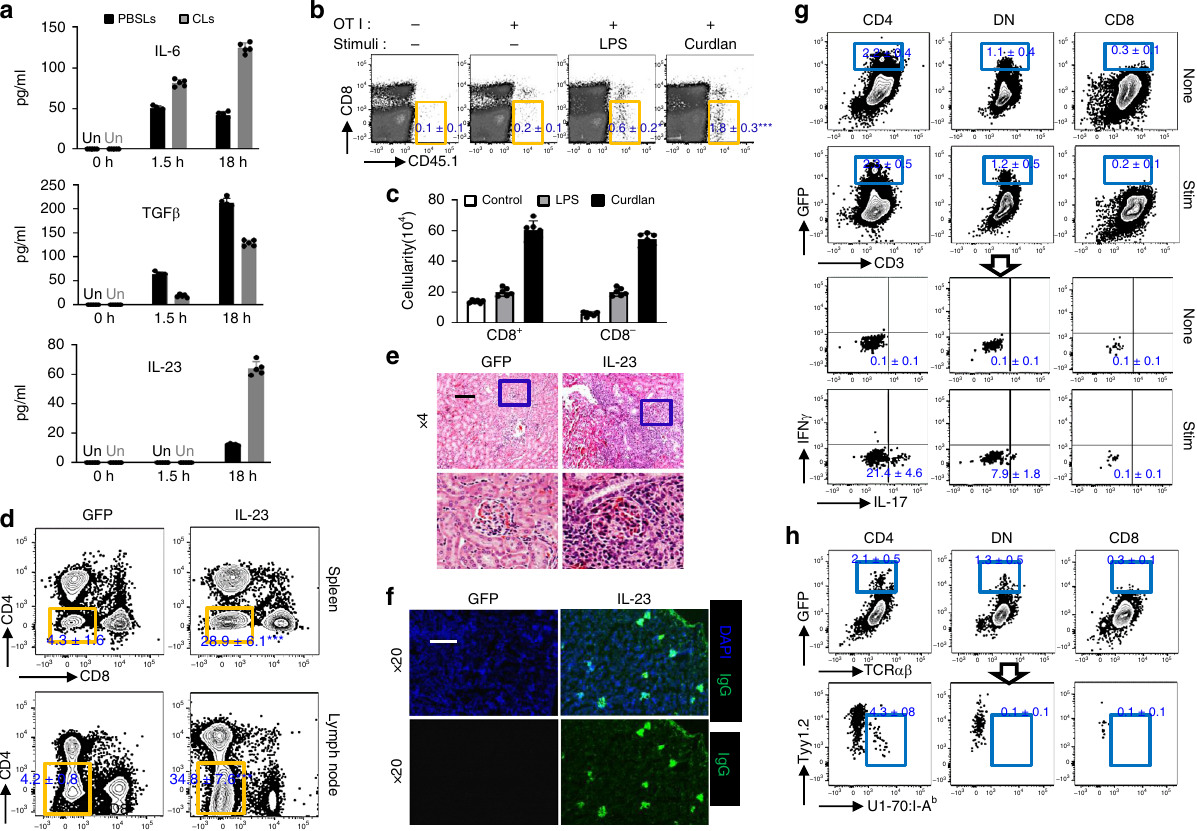
Fig. 4 IL-23 favors DN T-cell formation. B6 mice were i.p. injected with apoptotic thymocytes prepared from B6 mice 4 h after control liposome or CLs i.v. administration, and blood was collected after indicated time. a ELISA analysis of indicated cytokines in the serum from indicated mice after indicated time, n = 5 per group. b , c CD8 T cells from Cd45.1 OT-I TCR Tg Rag1 − / − B6 mice were i.v. transferred into B6 mice. Twelve hours later, recipients were administered with apoptotic thymocytes prepared from m-OVA Tg B6 mice plus PBS, LPS (2 mg/kg) and Curdlan (5 mg/kg) separately. Mice were euthanized after an additional 72 h. n = 6 per group. b Flow cytometry analysis of CD8 expression on transferred OT-I CD8 T cells from spleens of indicated recipients. c Bar graphs show quantitation of the absolute cell numbers of both CD8 + and CD8 - CD45.1 + OT-I T cells from the spleens of indicated recipients. d Flow cytometry quantitation of the percentage of CD3 + TCRb + CD4 − CD8 − DN T cells in spleens or lymph nodes from mice with the indicated MC administration. e Representative H&E images of kidneys from mice with indicated MC administration. Upper: magni fi cation, ×4, scale bar: 200 μ m; Lower: digitally magni fi ed views of the boxed areas in the upper panels. f Fluorescence microscopic images of IgG staining in the kidneys of mice with indicated MC administration. Magni fi cation, ×10, scale bar: 100 μ m. g IL-23 MC was administered to 2-months-old IL-17 GFP B6. lpr mice. Three months after administration, splenic T cells were puri fi ed and co-cultured with or without irradiated wild-type B6 splenocytes pre-loaded with U1-70 peptide. Top: fl ow cytometry quantitation of the percentage of GFP + cells CD4, CD8 and DN T cells individually. Bottom: fl ow cytometry analysis of the production of IL-17 and IFN γ in GFP + populations from indicated T cells. h Flow cytometry quantitation of the percentage of U1-70:I-A b tetramer-positive cells in GFP + population from indicated T cells. Data represent the mean ± SEM (* P < 0.05, *** P < 0.005 vs. control, Student ’ s t test; n = 4 mice per group for two independent experiments for ( e – h dendritic cells, was only observed in the absence of MZMs (Fig. 5f). Of note, RPMs were well preserved after CL treatment, and follicular translocation of these cells after AC administration in the absence of MZMs suggested follicular Ag transportation by RPMs may drive the activation of T and B cells against self- antigens (Fig. 5e). Flow cytometry analysis further con fi rmed our observation. Collectively, our results strongly suggest that under naive status, MZMs are the main cellular source of TGF β 1 to maintain immune tolerance to apoptotic cells. To assess whether Tgfb1 de fi ciency in macrophages promotes DN T-cell formation in our fi ndings in lupus-prone mice, we backcrossed Lyz2 cre + Tgfb1 fl / fl mice to B6. lpr mice. Enlarged spleens and lymph nodes with signi fi cantly increased cell counts were observed (Fig. 5h; Supplementary Fig. 14). FACS analysis revealed that there were signi fi cantly increased percentages of DN T cells in the spleens of Lyz2 cre + Tgfb1 fl / fl B6. lpr mice than in